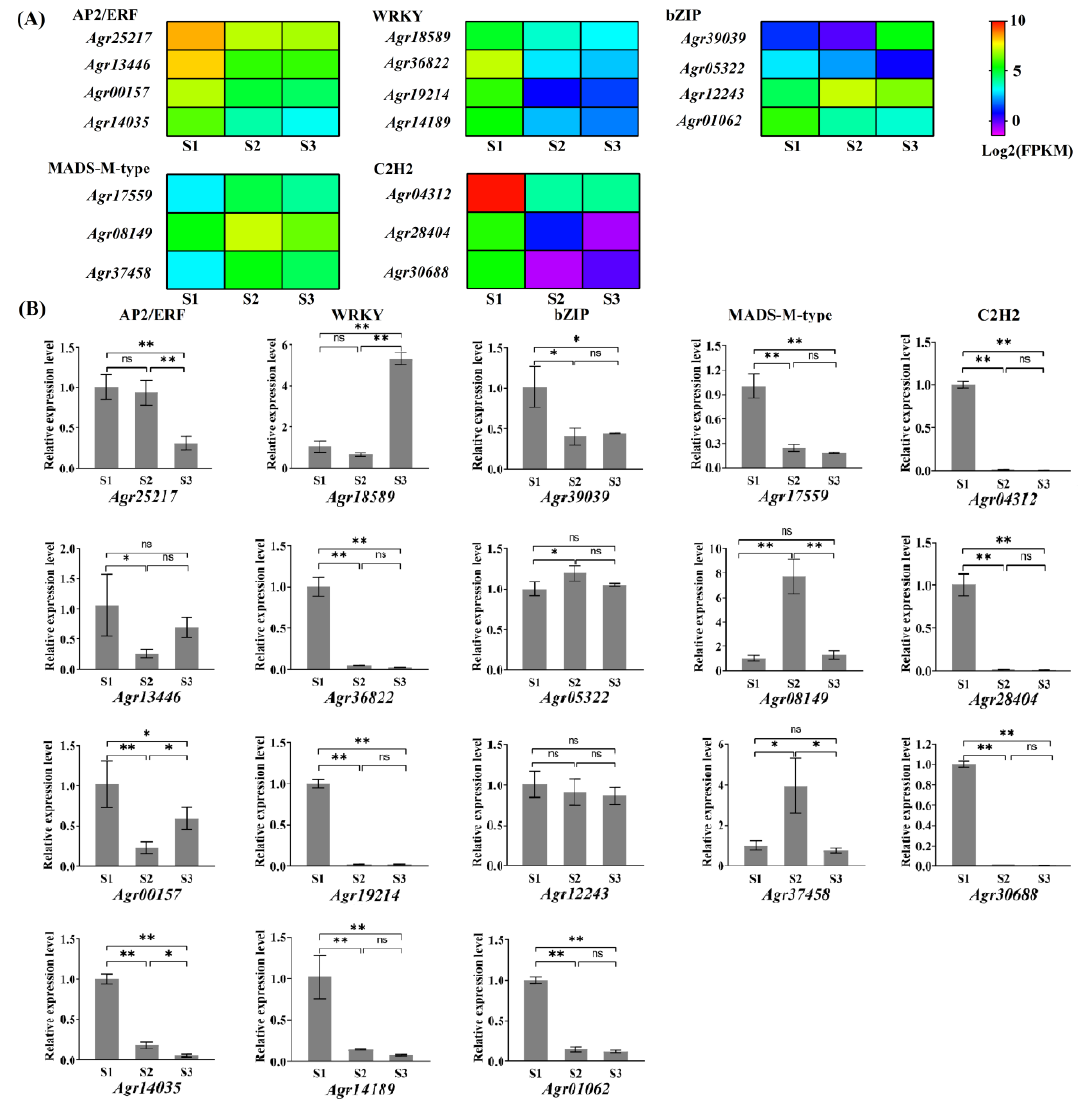
Figure 7. Cluster analysis of transcription abundance and the results of relative expression level of verified genes at different flower development stages. ( A ) Heat map showing transcriptional abundance of DEGs. FPKM-values were log2-based. ( B ) Relative expression level of genes detected by qPCR. The data are presented as the mean ± SD of three biological and technical replicates.